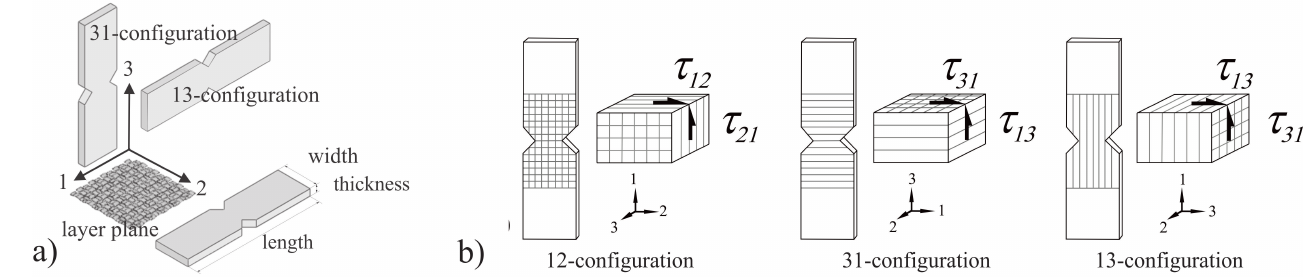
Figure 1. ( a ) Specimen configurations with respect to the fibre reinforcement plane and ( b ) the corresponding stress states during I OSIPESCU testing